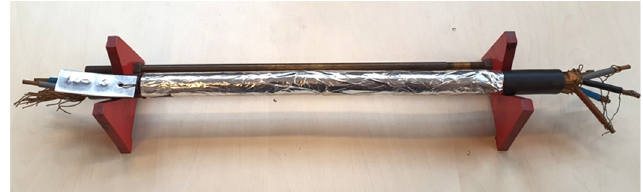
Figure 2. Cable sample prepared for measurement. The inner conductor is the screen tape connected to all core conductors; the outer one is an aluminum foil wrapped around the cable.